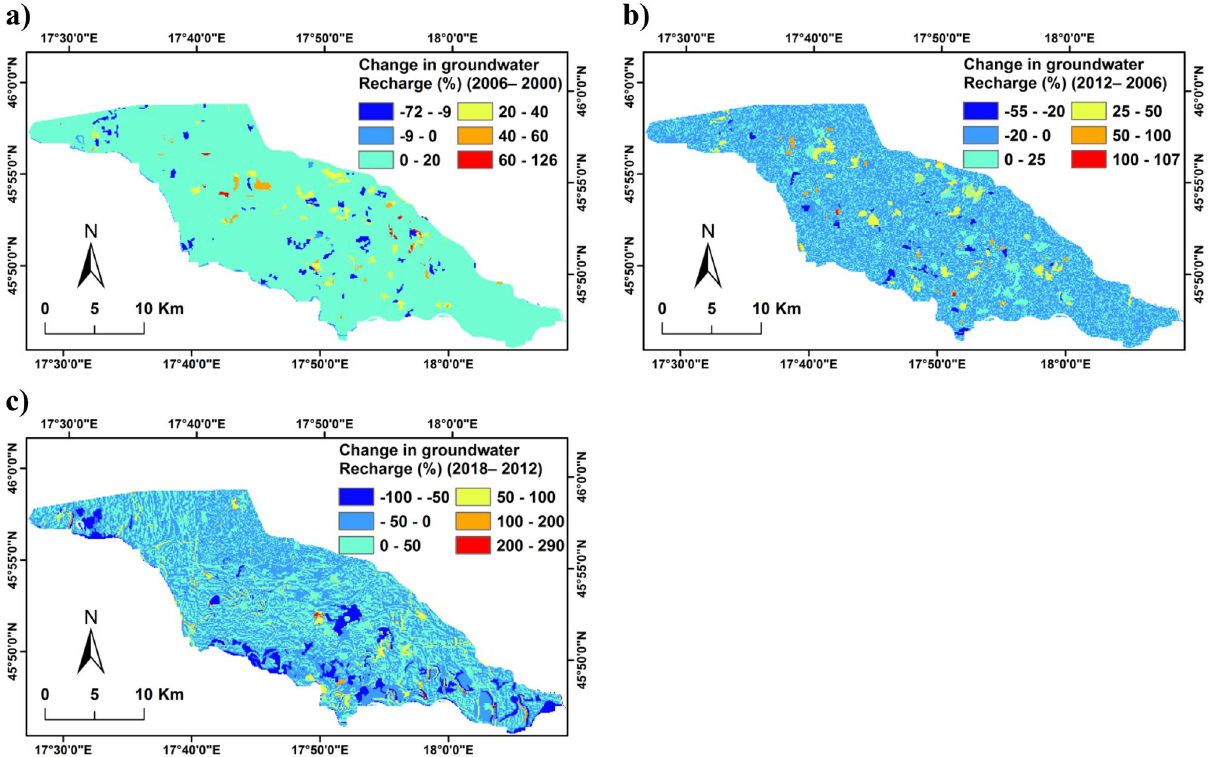
Figure 8. Change in groundwater recharge: ( a ) 2006–2000; ( b ) 2012–2006; ( c ) 2018–2012.